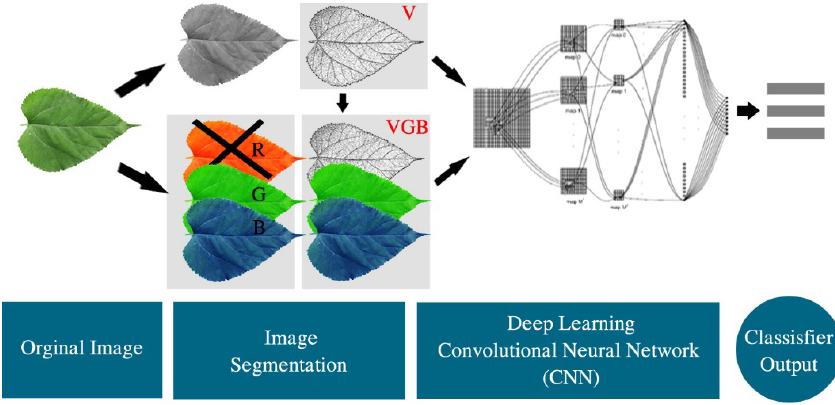
Fig. 2. Scheme of proposed